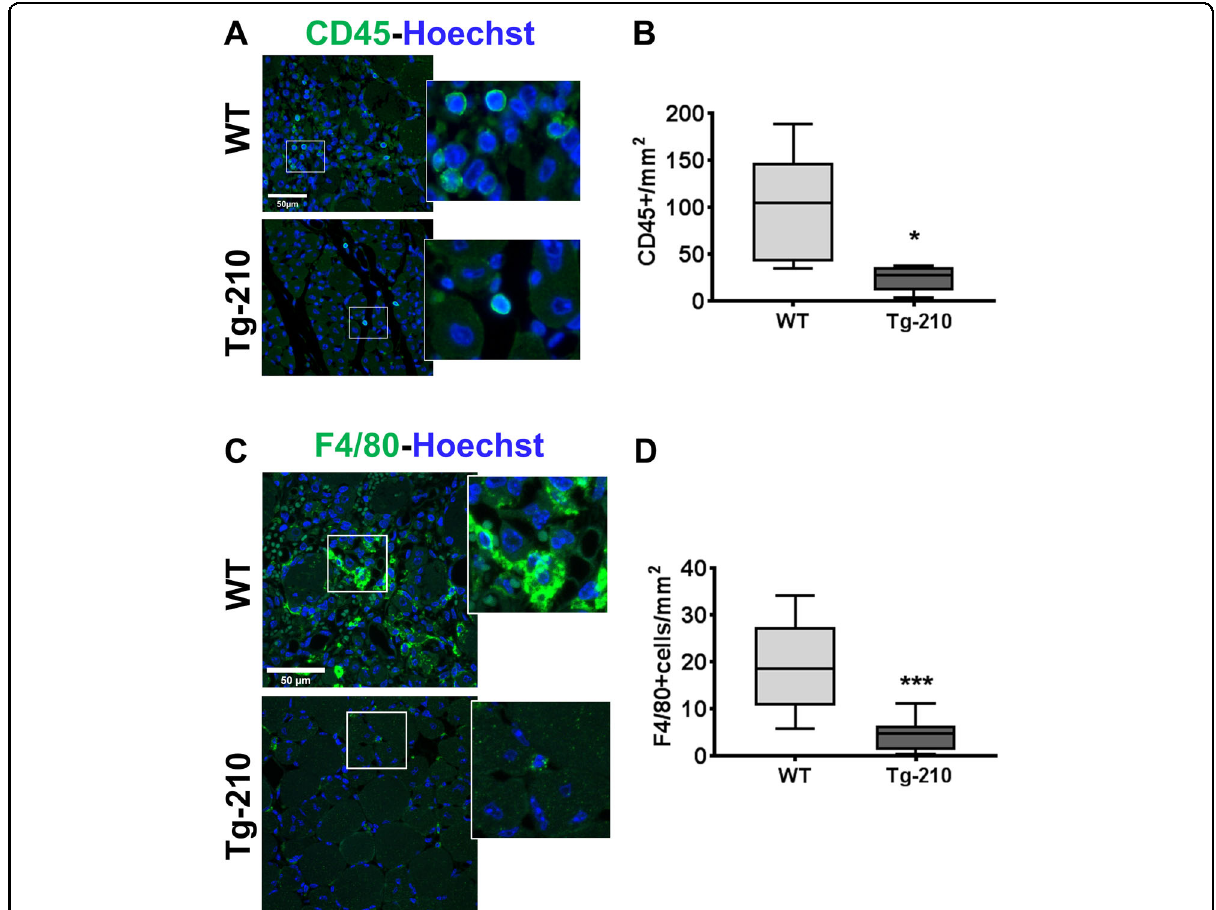
Fig. 1 Ubiquitous miR-210 over-expression attenuates the in fl ammatory response after hindlimb ischemia. A Representative immuno fl uorescence staining for CD45 (green), a common leukocyte marker expressed in all nucleated hematopoietic cells, of gastrocnemius muscle sections of Wt and Tg-210 mice, 7 days after ischemia. Nuclei were stained by Hoechst (blue). Images are presented as merge. Magni fi cation ×400. Calibration bar 50 µm. B Quanti fi cation of CD45-positive cells/mm 2 ( n = 5, test T * P < 0.03). C Representative immuno fl uorescence staining for F4/80 (green), a pan-macrophage marker, in gastrocnemius muscle sections of Wt, and Tg-210 mice, 7 days after ischemia. Nuclei were stained by Hoechst (Blue). Images are presented as merge. Magni fi cation 63 × 0.5. Calibration bar 50 µm. D Quanti fi cation of F4/80-positive macrophages/mm 2 ( n = 6 – 7, ** P < 0.009). In both A , C insets show magni fi cation of the indicated